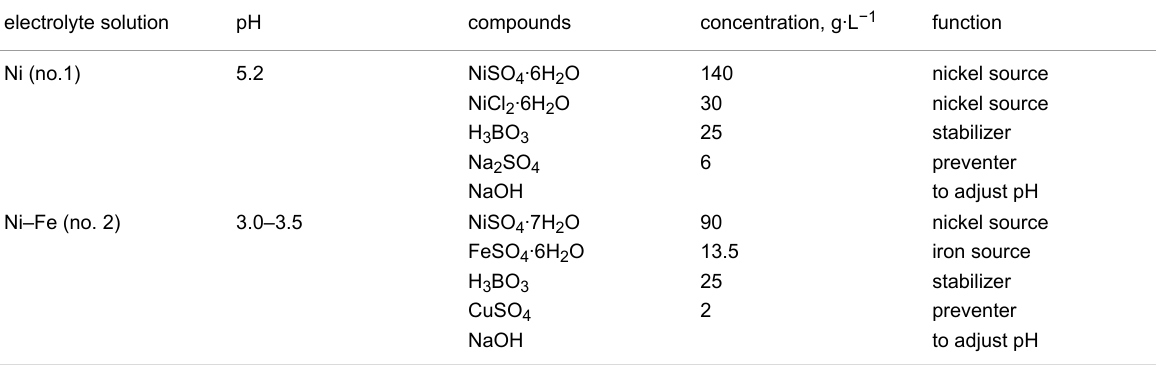
Table 1: Characteristics of electrolyte solutions used for galvanostatic dc electrodeposition of Ni and